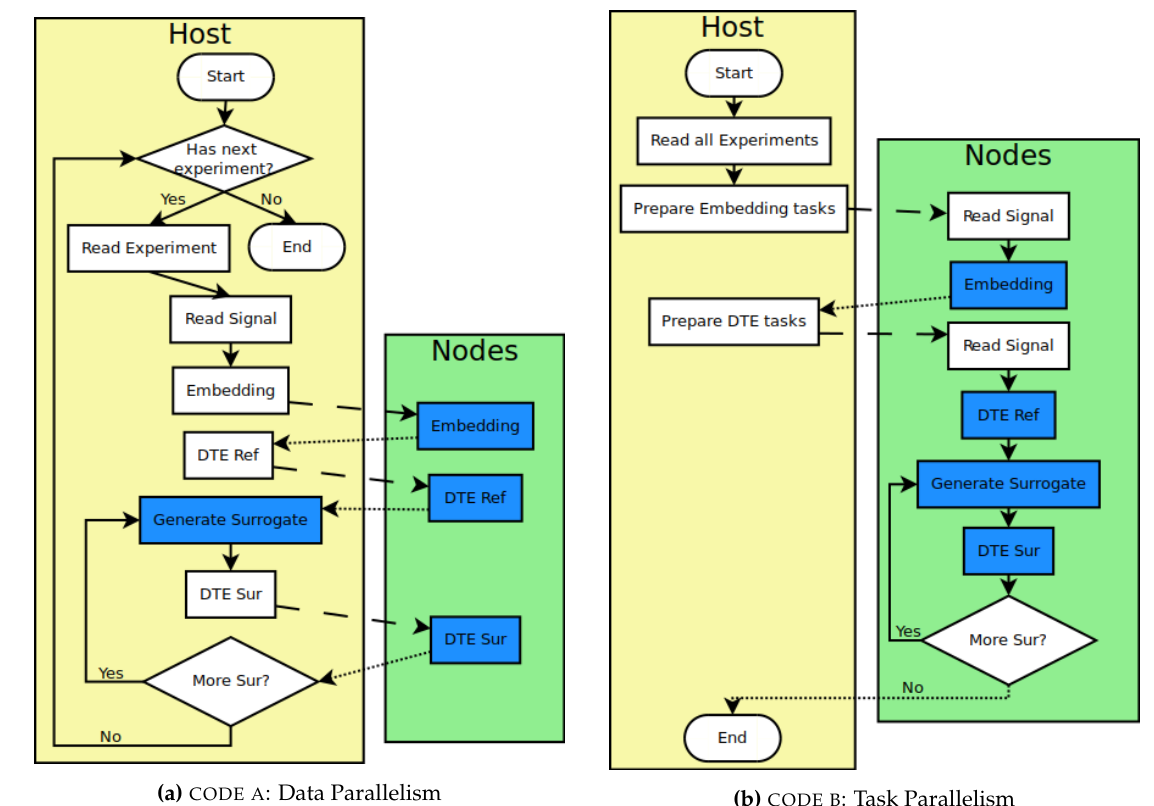
Figure 2. Data and Task Parallelism algorithm flowcharts. Note that each dashed line means data transfer to every cluster node and every dotted line means data gathering and synchronization to host node. Objects of this study are highlighted in